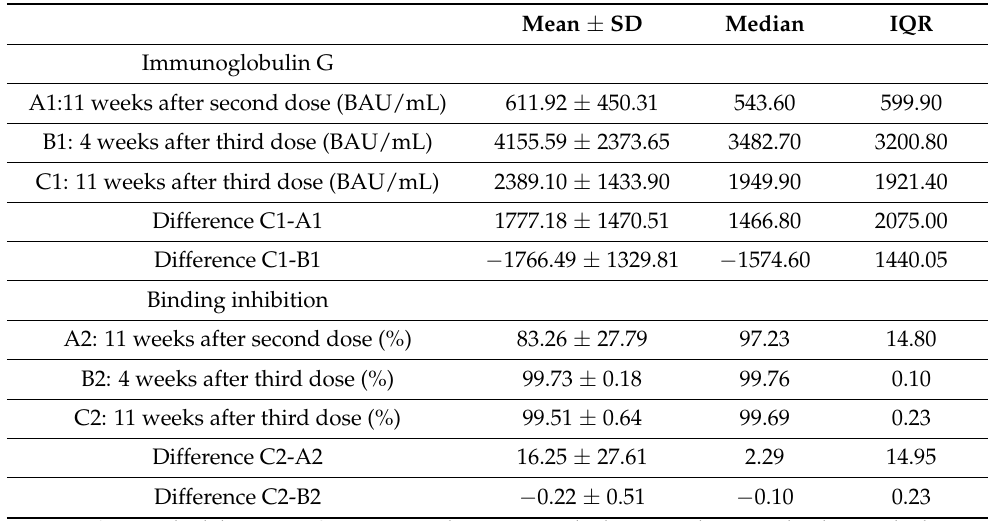
Table 2. Antibody titers and binding inhibition capabilities of neutralizing antibodies at different timepoints within the study cohort ( n =